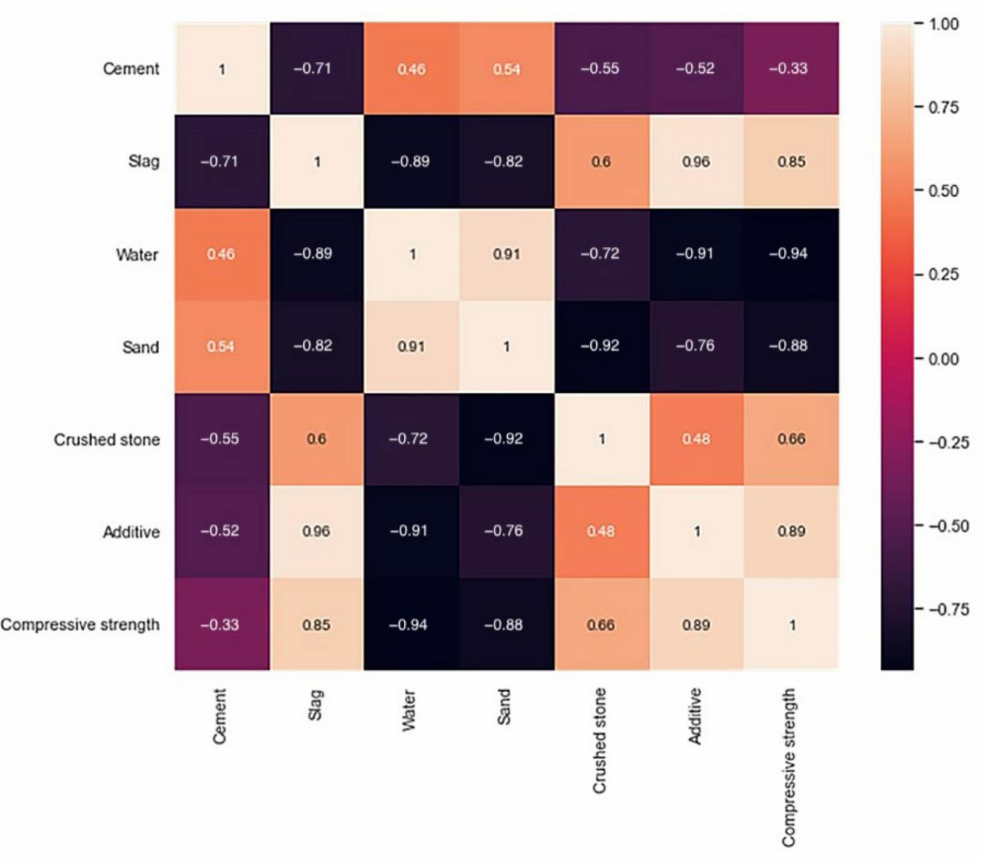
Figure 3. Correlation matrix. Table 2. Statistical characteristics of the original